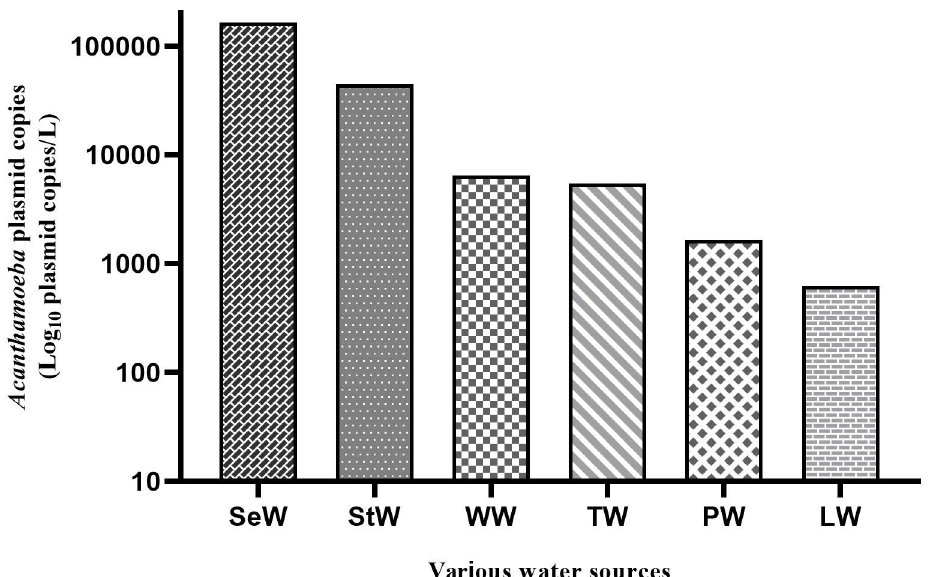
Fig 3. DNA quantity of Acanthamoeba plasmid copies determined by qPCR assay in various water sources from İ zmir, Turkey.